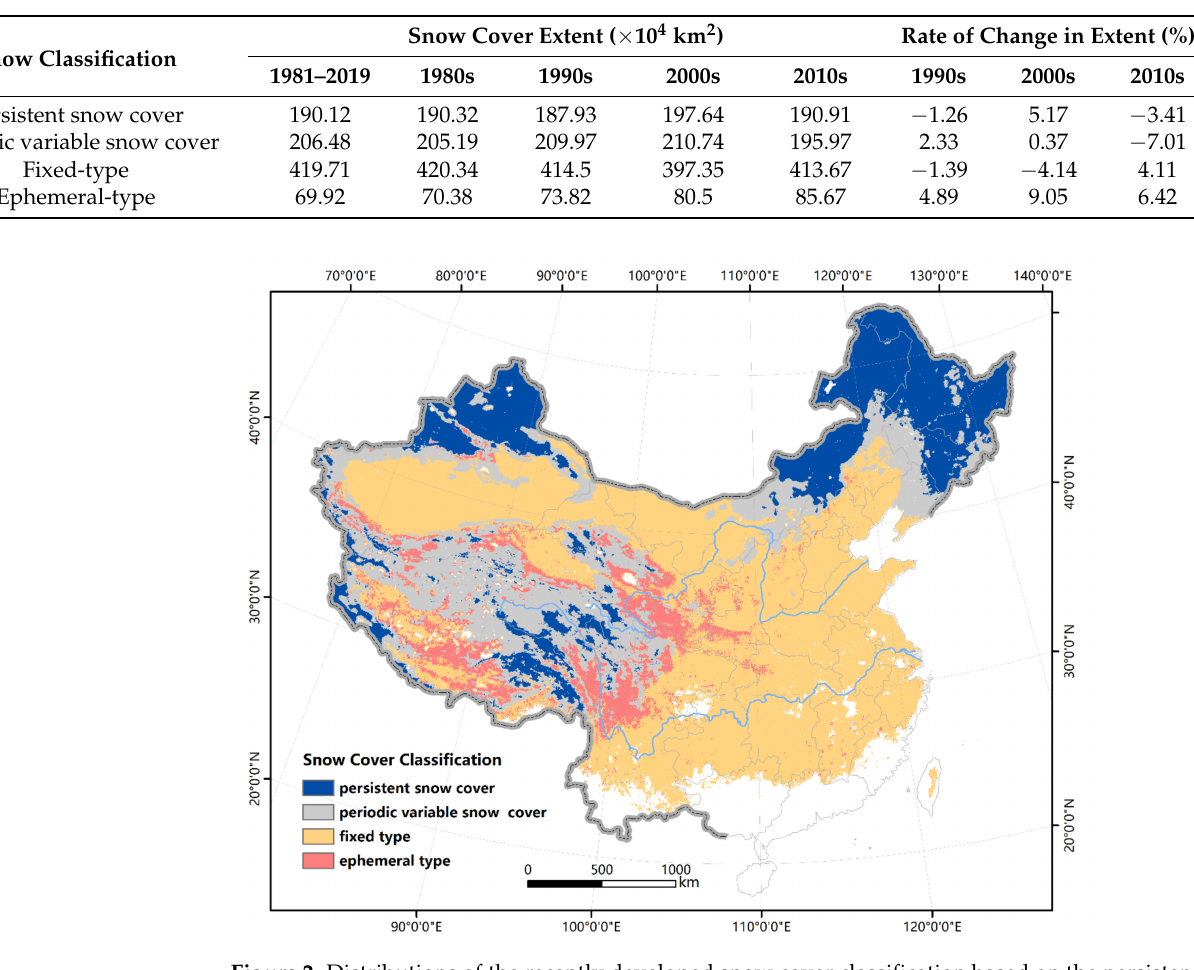
Figure 2. Distributions of the recently developed snow cover classification based on the persistence across China during